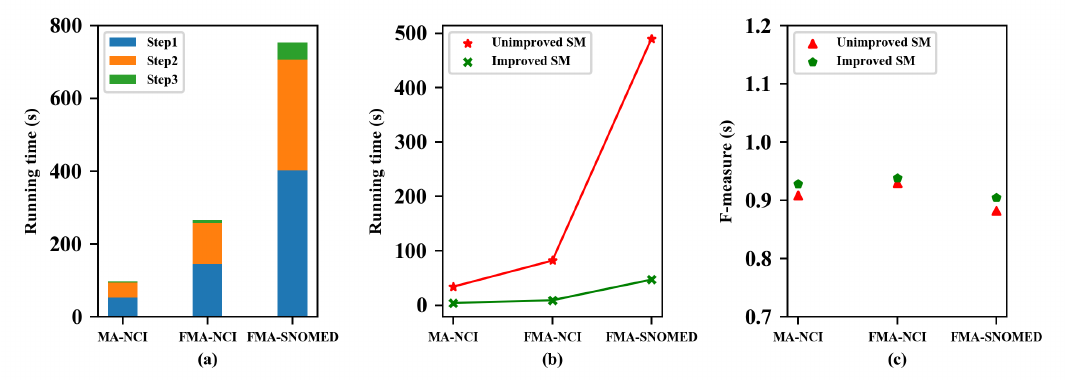
Figure 5. ( a ) Runtimes of the steps in the proposed algorithm. ( b , c ) Analysis of the running time and F-measure of improved Stable Marriage (SM)